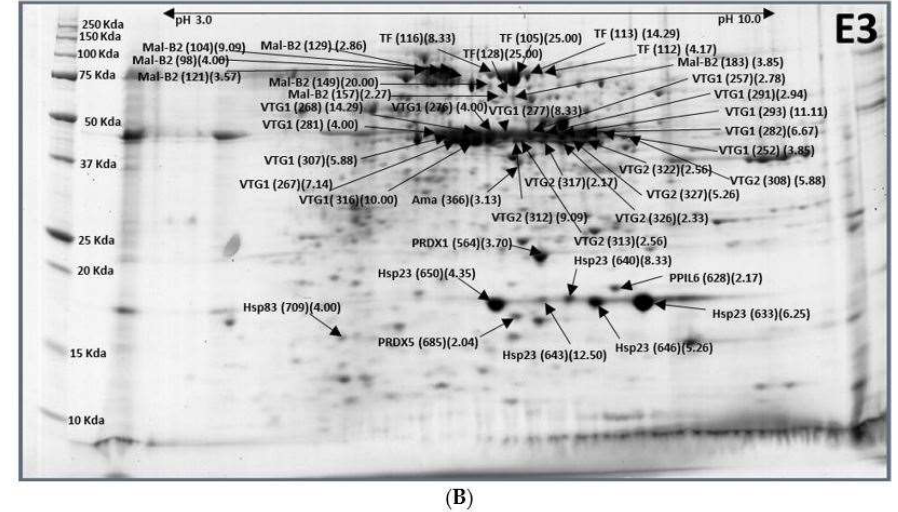
Figure 1. Representative images of 1-day-old larvae ( A ) and 3-day-old egg ( B ) of Bactrocera latifrons . Images were labelled with protein names (spot ID#) (L1/E3 ratios).